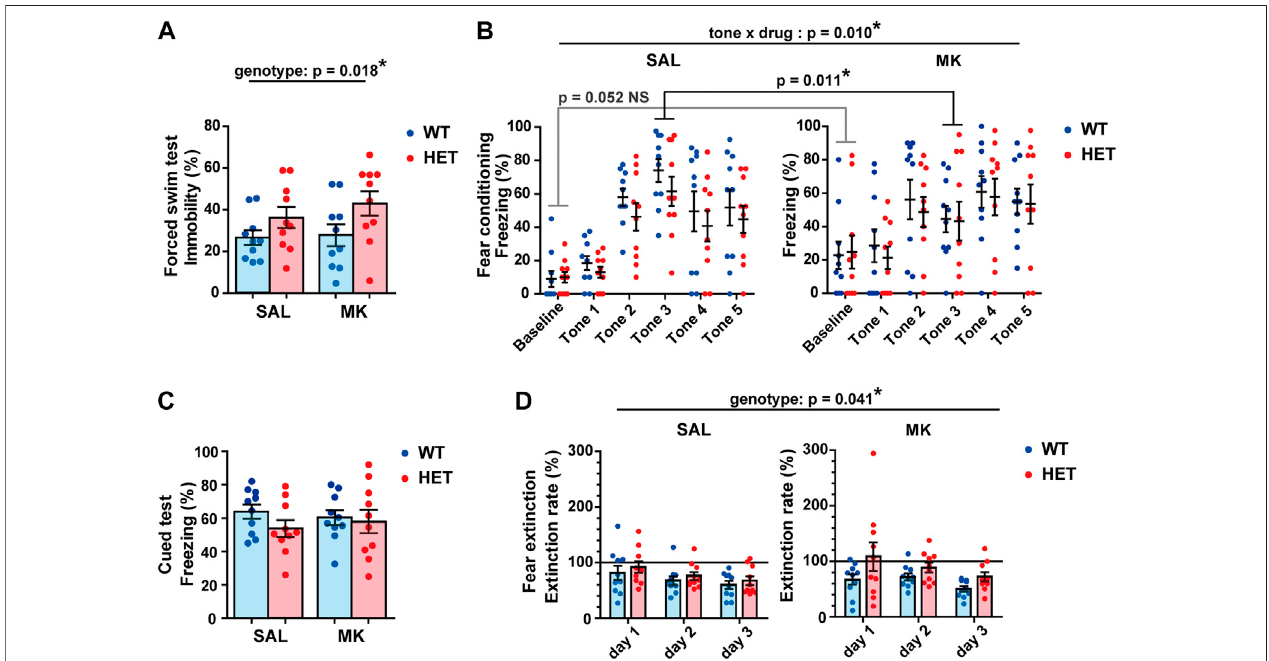
FIGURE 4 | Gad1 HET rats showed increased immobility and delayed fear extinction in the forced swim test. (A) HET rats showed a longer immobility duration during the forced swim test ( p (cid:2) 0.018), while MK-801 treatment did not have any effect. (B) The training for cued fear conditioning. MK-801 treatment altered the time course of the freezing level during training (tone × drug, p (cid:2) 0.010). The baseline freezing was slightly higher in MK groups but it was at a subthreshold level ( p (cid:2) 0.052). However, the freezing time of MK groups was signi fi cantly shorter in tone 3 ( p (cid:2) 0.011). (C) The freezing time during the cued test was comparable between the